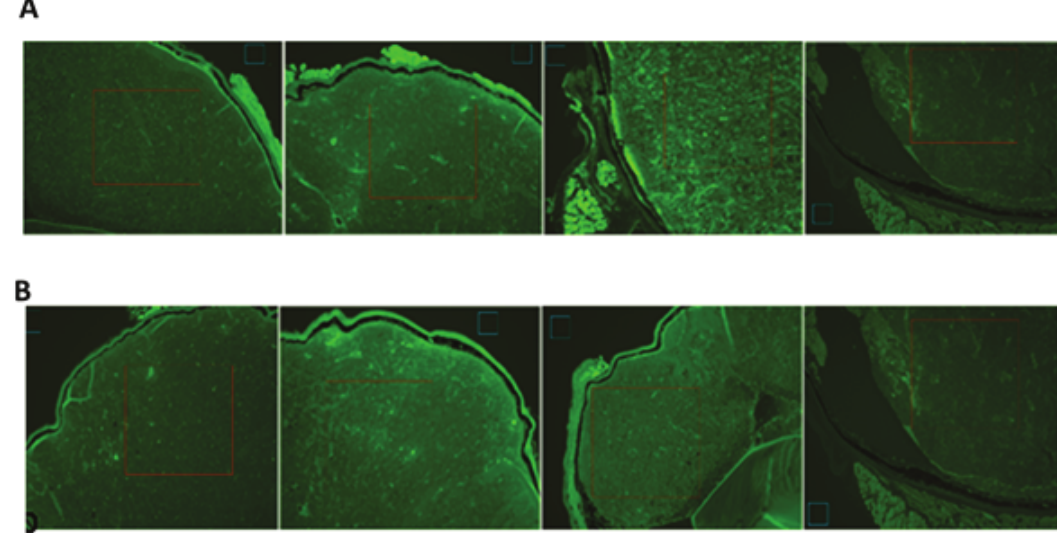
Figure 1. (A) From left to right, eyes injected with CNT-FITC-Bio on days 1, 2, and 3 and control eye ( × 10, DAPI). (B) From left to right eyes injected with CTN-FITC-FA on days 1, 2, and 3 and control eye ( × 10, DAPI). The blue squares in each image denotes the area in glass region, which is used for normalization. The red squares were used to calculate the averaged intensity within tumor. FITC-functionalized CNTs appear as bright spots throughout the retinoblastoma tumor in colored images.